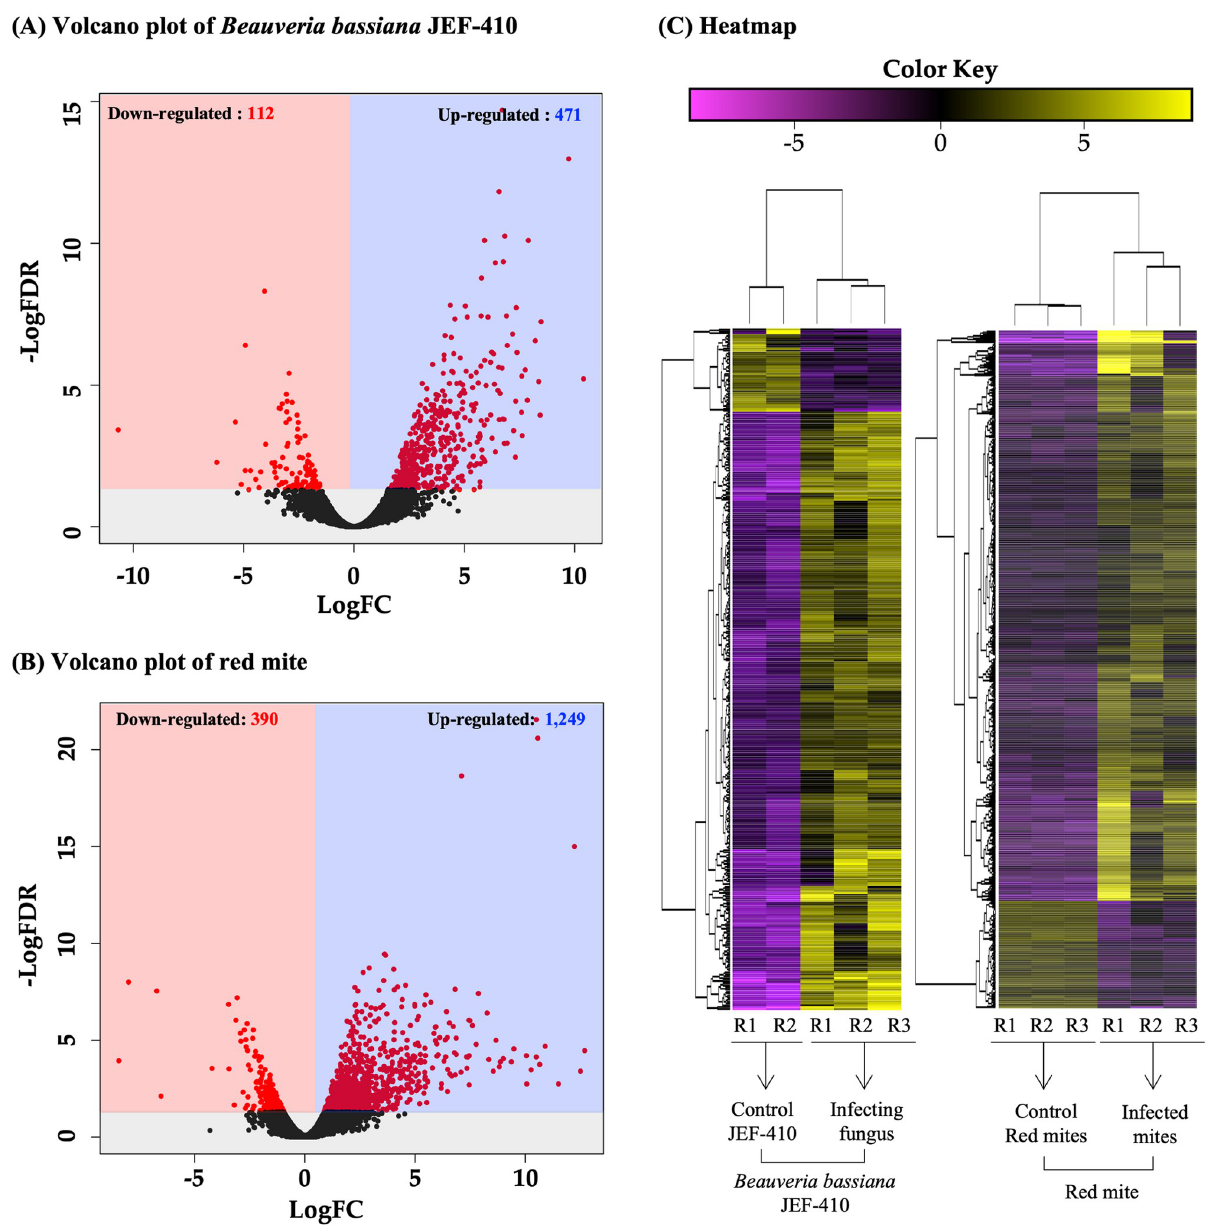
Fig 1. Volcano plot and heatmap of Beauveria bassiana JEF-410 and red mite DEGs. Distribution of DEGs in Beauveria bassiana JEF-410 and red mites. (A) Volcano plot comparing log2 ratios of TPM expression values (FDR < 0.05) of non-treated control fungus vs. red mite-infecting fungus. (B) Volcano plot comparing log2 ratios of TPM expression values (FDR < 0.05) of non-treated control red mites vs. fungal-infected red mites (C) Heat map of B . bassiana JEF-410 and red mite. The meaning of the ‘R’ attached to each number is the repetition of the sample. (GO:0055085), and localization (GO:0051179). The up-regulated genes of the cellular com- ponent were annotated to protein-DNA complex (GO:0032993), chromatin (GO:0000790), DNA packaging complex (GO:0000786), and catalytic complex (GO:1902494), and down- regulated genes were annotated to the prefoldin complex (GO:0016272). There was a signifi- cant difference between DEG groups in molecular function. The up-regulated genes were annotated to GO terms related to catalytic activity (GO:0003824), binding (GO:0003677),